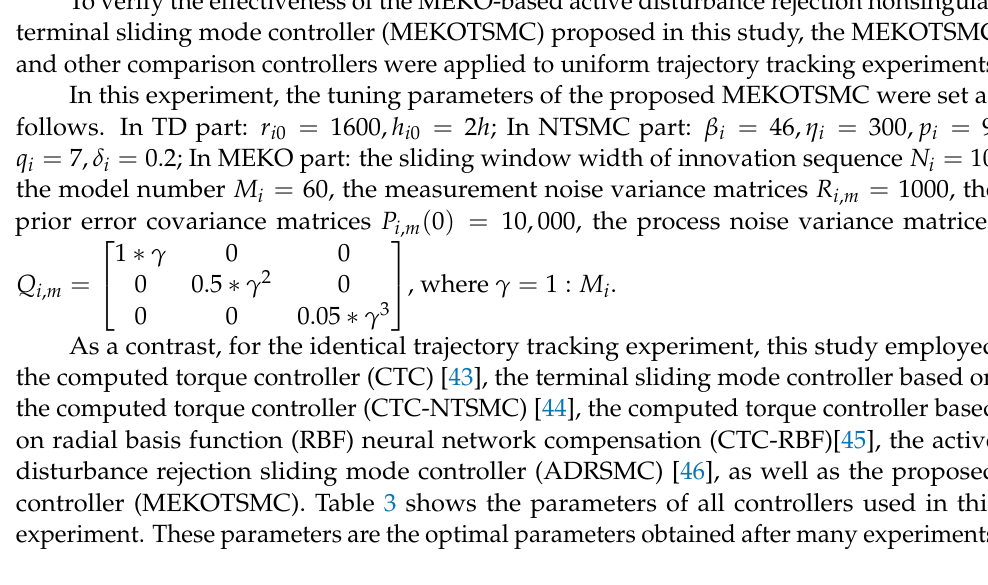
Table 3. Compared controller parameter